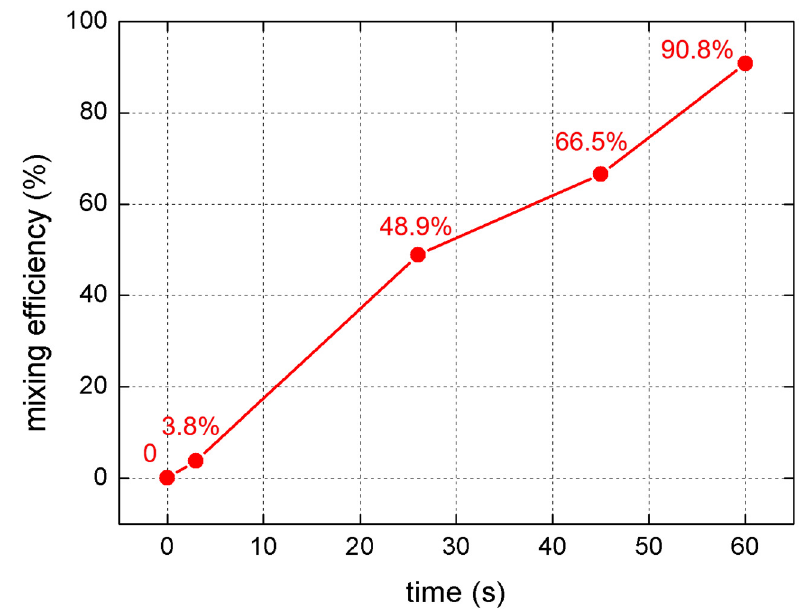
Figure 5. Variation of mixing efficiency.